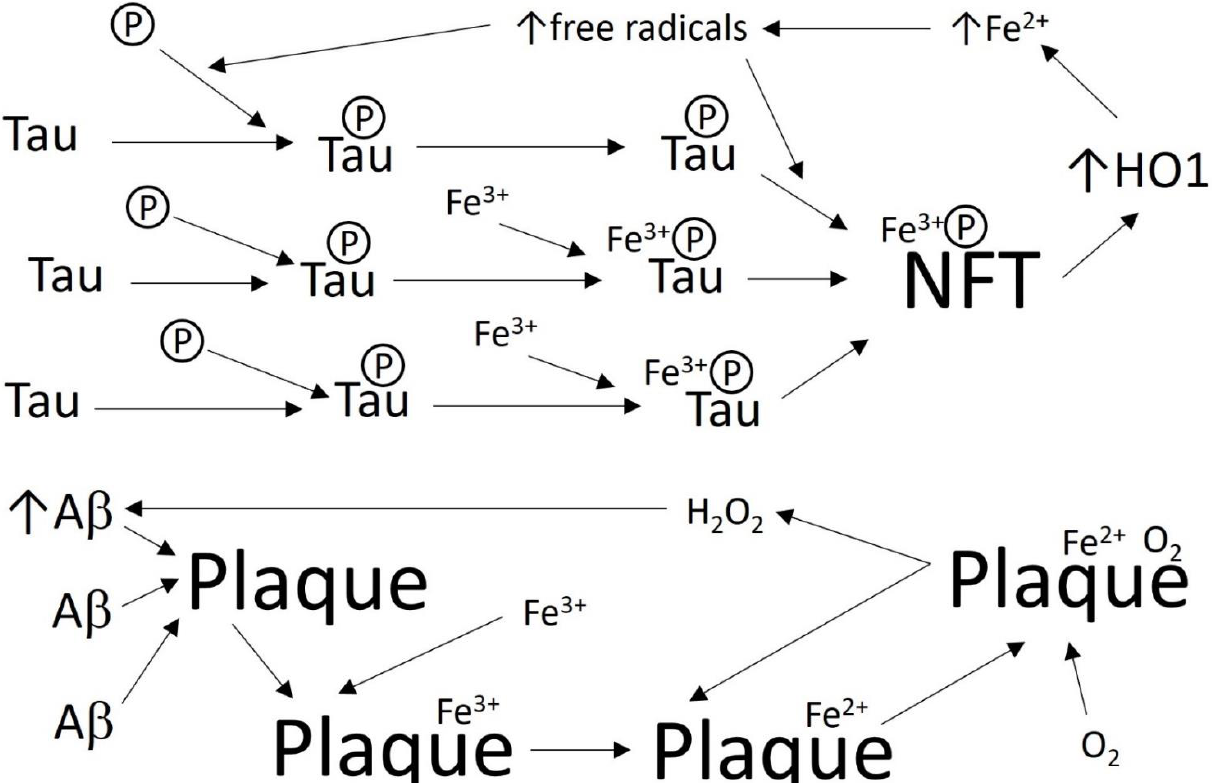
Figure 1. Some interactions of iron with AD pathology. Iron may increase in AD, accumulating on plaques and NFTs [16,18]. In AD, some tau is hyperphosphorylated (a phosphate group is shown as a circled P). Fe 3+ can bind tau and increase its aggregation and induction of heme oxygenase 1 (HO1), which raises Fe 2+ , which in turn raises free radicals, which then increases tau aggregation, for example by stimulating tau phosphorylation [16,17]. A β aggregates to form plaques, and iron on plaques makes H 2 O 2 by the Fenton reaction, as follows: Fe 3+ binds plaque A β , which reduces Fe 3+ to Fe 2+ , and then binds O 2 and converts it, using the Fe 2+ , to H 2 O 2 [18]. In a positive feedback loop, H 2 O 2 increases A β [10].